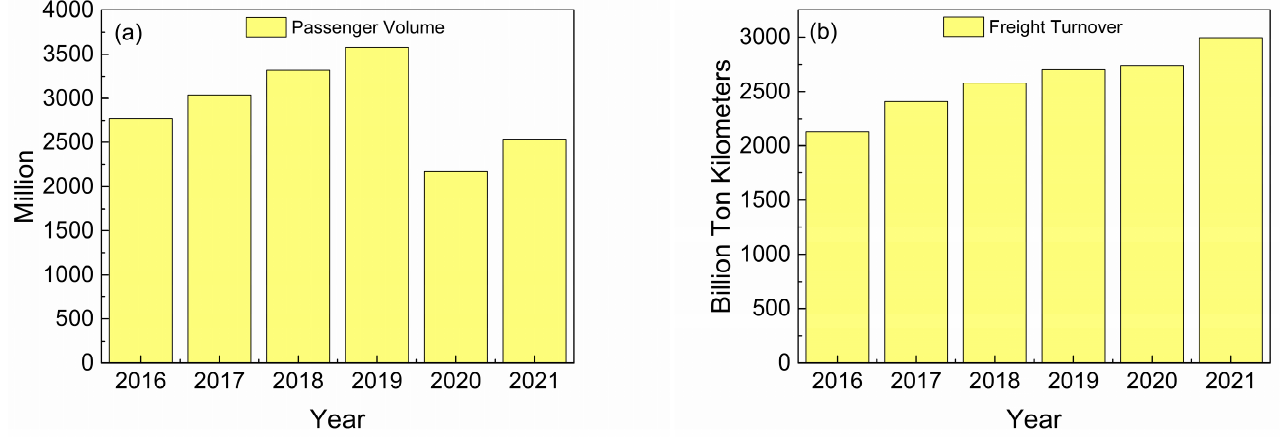
Figure 1. ( a ) Total railway passenger volume in China in 2021. ( b ) Total railway freight turnover in China in 2021.